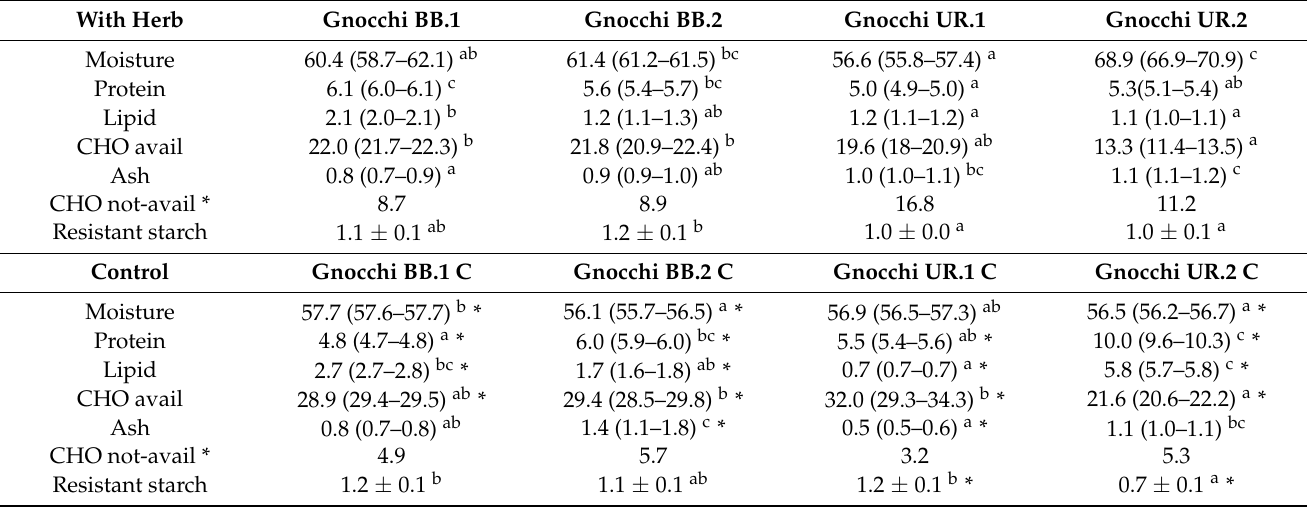
Table 5. Chemical composition of